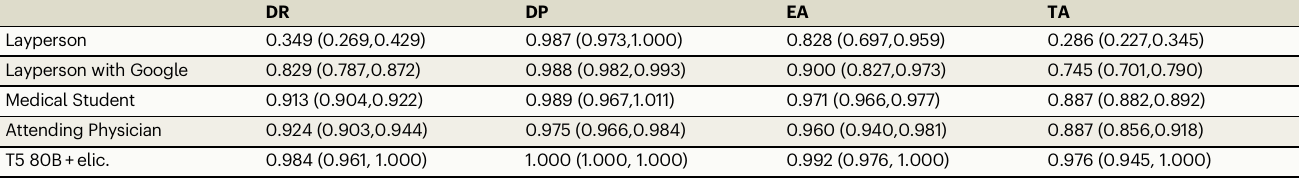
Table 2 | Performance of various human groups and models on the random selection of synthetic test set examples